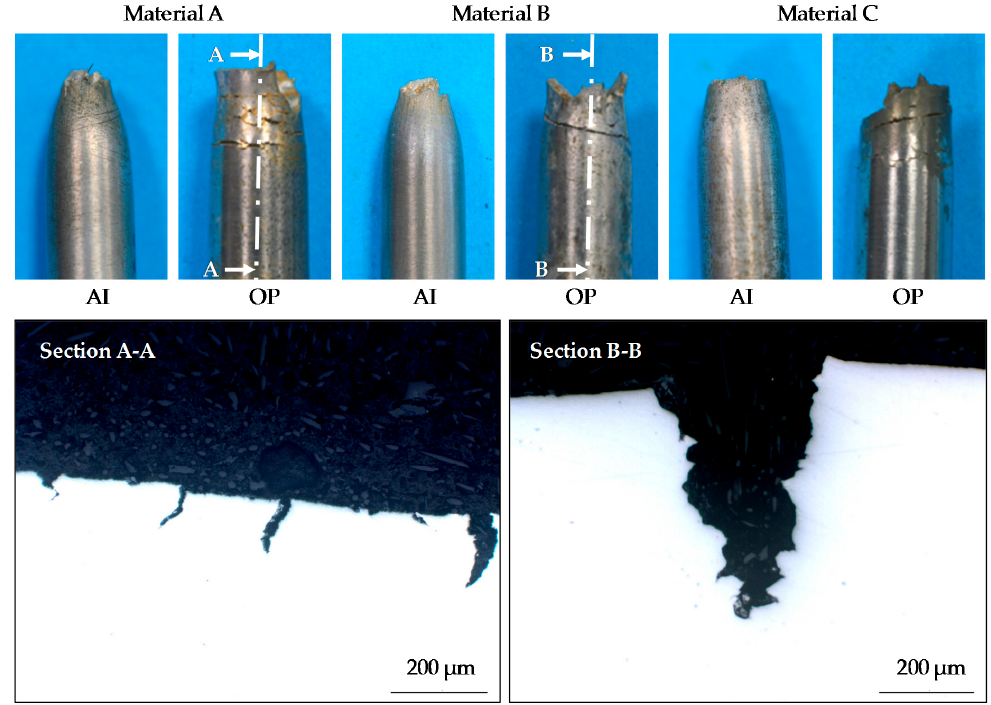
Figure 6. Top : Overview of the necking area of the specimens of each tested material in both extremes of HE aggressiveness (AI and OP); Bottom : Micrographs showing the surface cracks in the overprotected samples for materials A (multiple short cracks) and B (longer cracks but fewer) in the neighbourhood of the necking; both are resin mounted, polished down to Ra < 0.2 μ m and un ‐ etched.